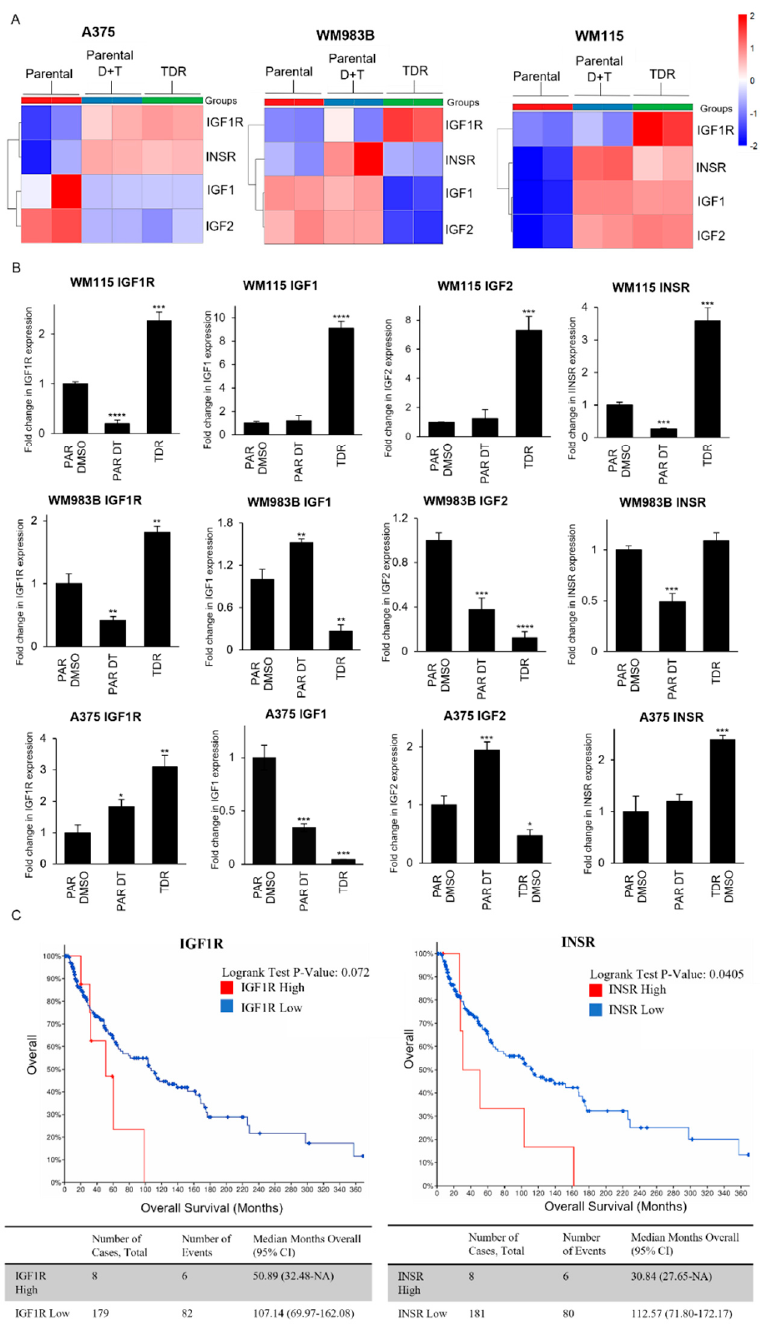
Figure 3. IGF1R and INSR are differentially expressed in TDR cells. ( A ) Heatmap of differentially expressed genes in parental cells, parental cells treated with combination of dabrafenib (D) and trametinib (T) (WM115: D: 800 nM, T: 200 nM; WM983B: D: 2.4 µ M, T: 500 nM; A375: D: 250 nM, T: 12.5 nM), or TDR cells. ( B ) Quantification of Actin ‐ normalized mRNA levels using real ‐ time quantitative PCR for IGF1R, IGF1, IGF2, and INSR for parental cells treated with DMSO or dabrafenib + trametinib and TDR following 24 h of treatment. * p < 0.05; ** p < 0.01; *** p < 0.001; **** p < 0.0001 by two ‐ tailed Student’s t ‐ test. Data are presented as mean ± SEM. ( C ) Kaplan Meier survival curve of skin cutaneous melanoma patients (TCGA, PanCancer Atlas) with data stratified for BRAF mutation along with IGF1R expression z ‐ score > 2 ( n = 8) and IGF1R expression z ‐ score < 2 ( n = 179) (Left panel); and INSR expression z ‐ score > 2 ( n = 8) and INSR expression z ‐ score < 2 ( n = 181) (Right panel).